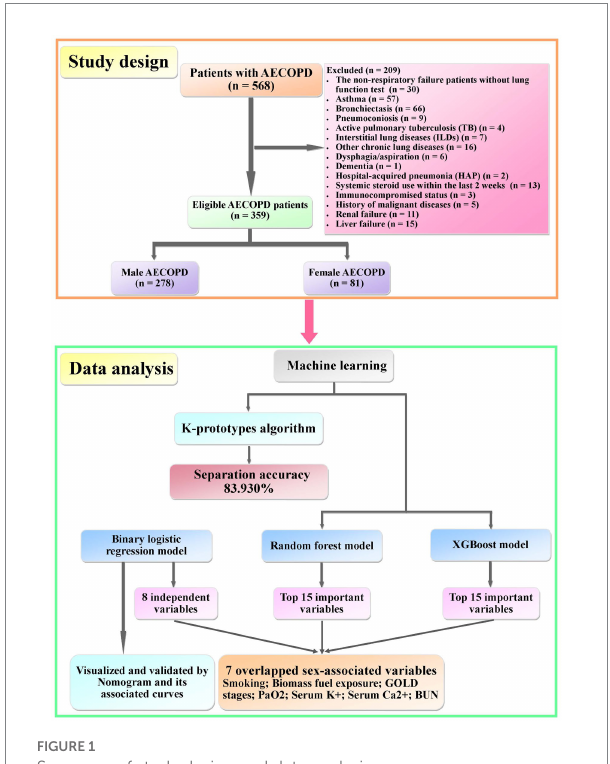
FIGURE 1 Summary of study design and data